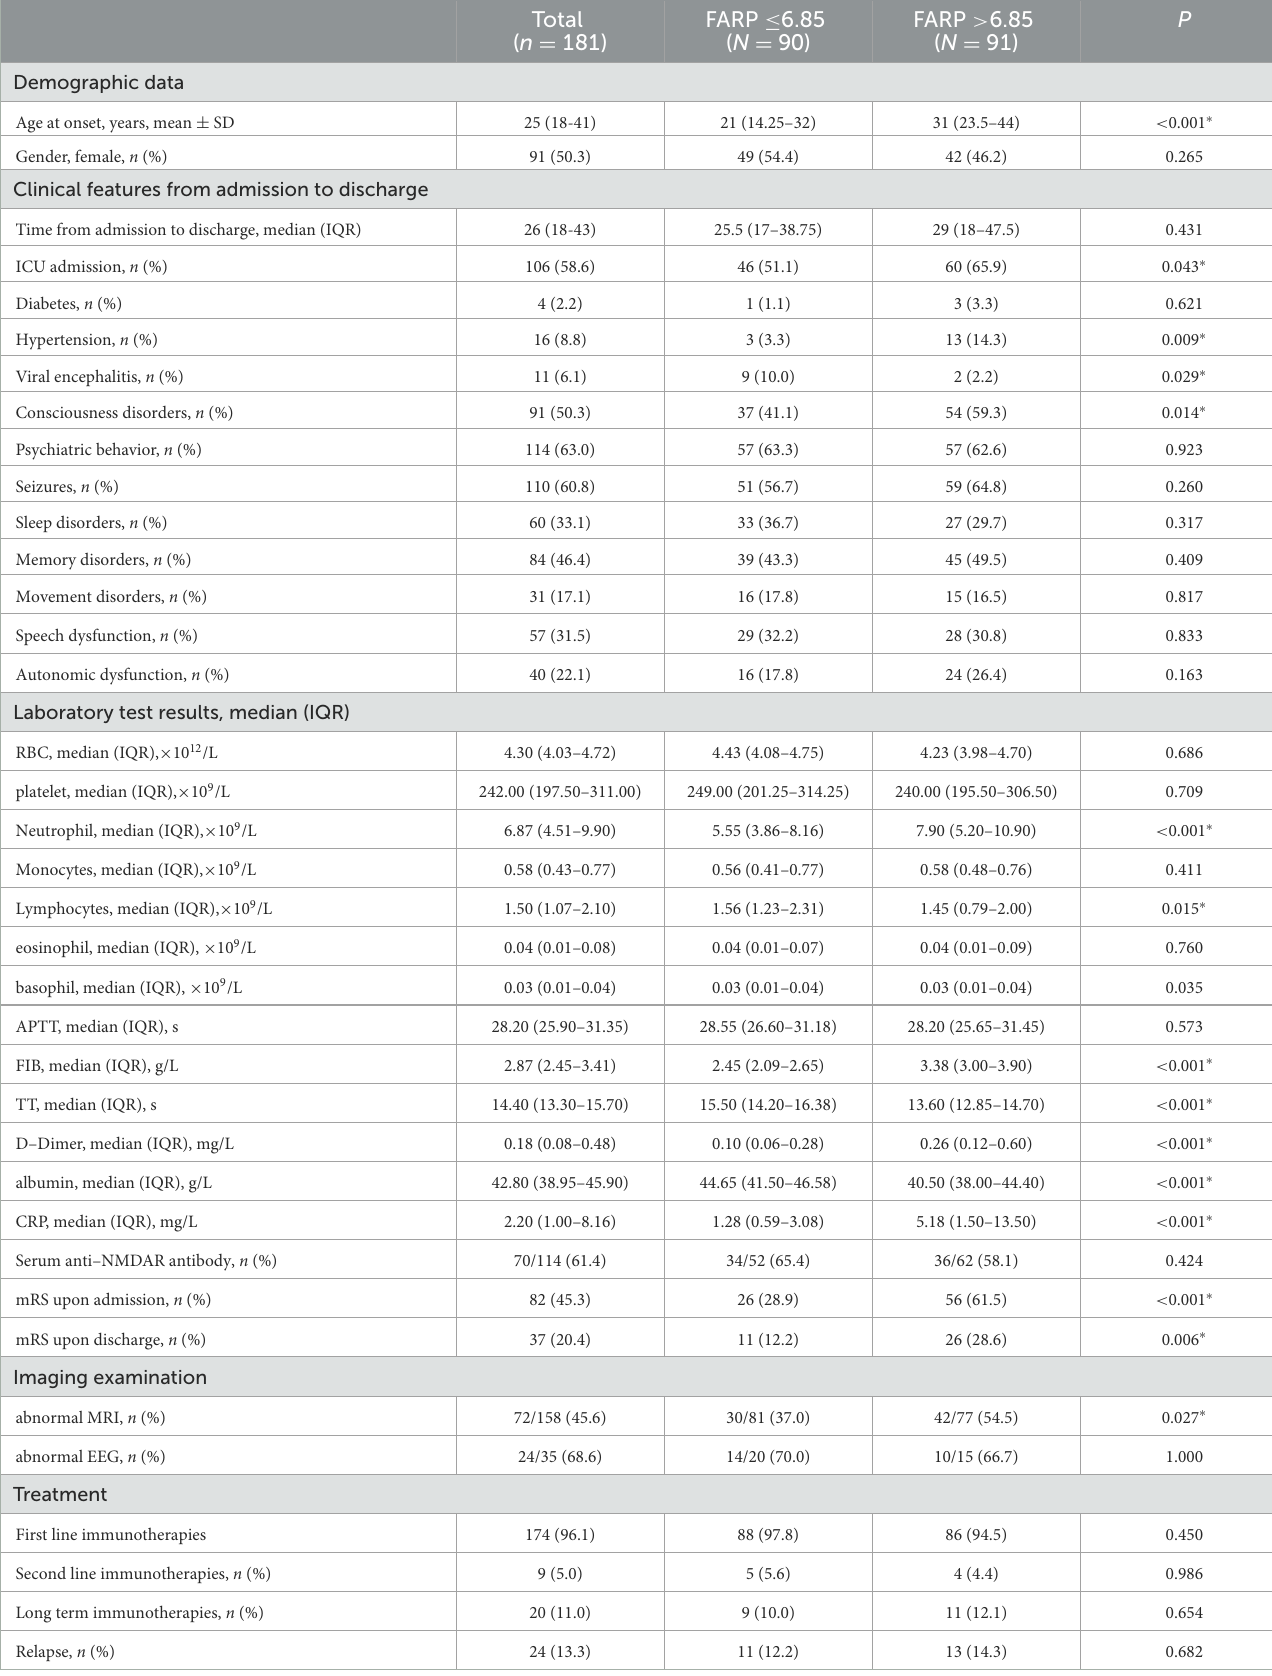
TABLE 4 Demographic and clinical data of patients with anti-NMDAR encephalitis in High FARP group (FARP ≤ 6.85) and Low FARP group (FARP > 6.85).